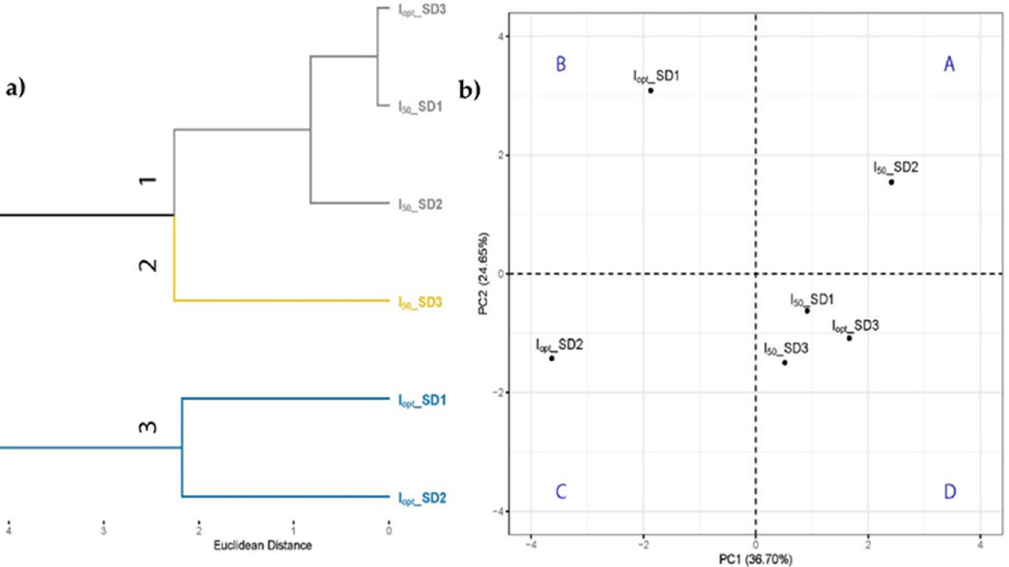
Figure 3. ( a ) Hierarchical cluster analysis (HCA) dendrogram for the sesquiterpenes compositions of the essential oils extracted from all cannabis accessions. Each connection (merge) of the two clusters is represented in the figure by splitting one horizon into two horizons. The horizontal position of the split, represented by a short vertical bar, indicates the distance (difference) between the two clusters. This analysis identifies two large pairs of treatment groups and their numbers are shown above the identification node. ( b ) Principal component analysis (PCA) score plot for the sesquiterpenes compositions of the essential oils extracted from all the samples. Table 4. Eigenvalues, the relative and cumulative percentage of the total variance, and correlation coefficient for sesquiterpenes compositions of the essential oils extracted with respect to the three principal components (PC1, PC2, and PC3).